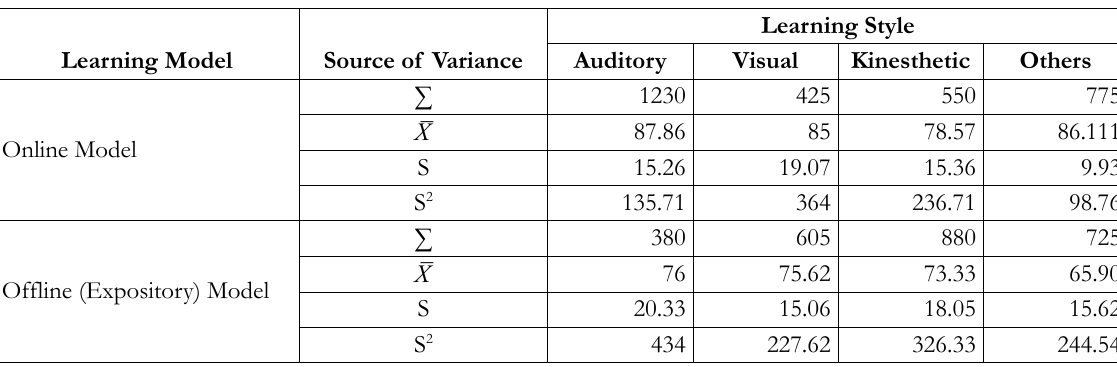
Table 11. Analysis of Variance in Learning Style of Both